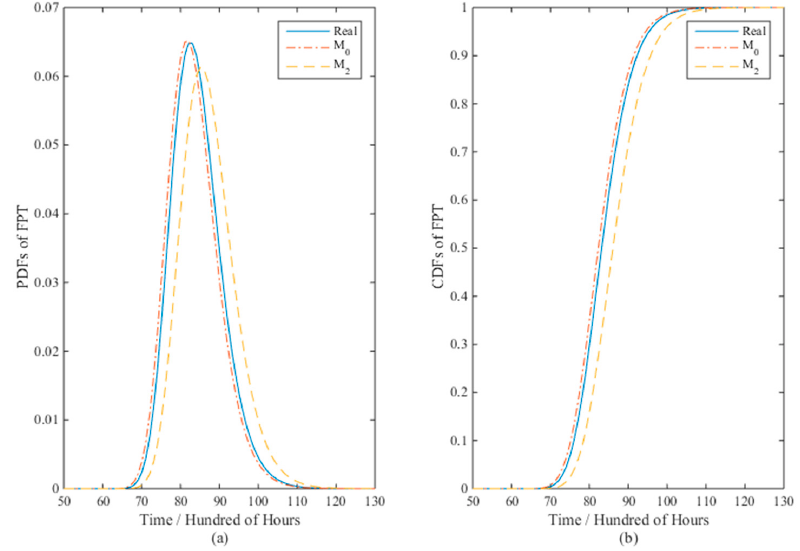
Figure 3. The ( a ) PDFs and ( b ) CDFs of the FPT for models M 0 and M 2 with the real values when n = 10.